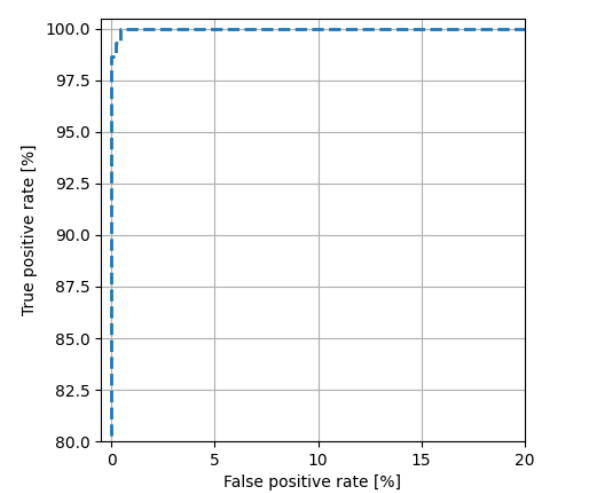
Figure 11. ROC curve for full fusion classification on the test set. Ranges of TPR and FPR were limited for visualization purposes.